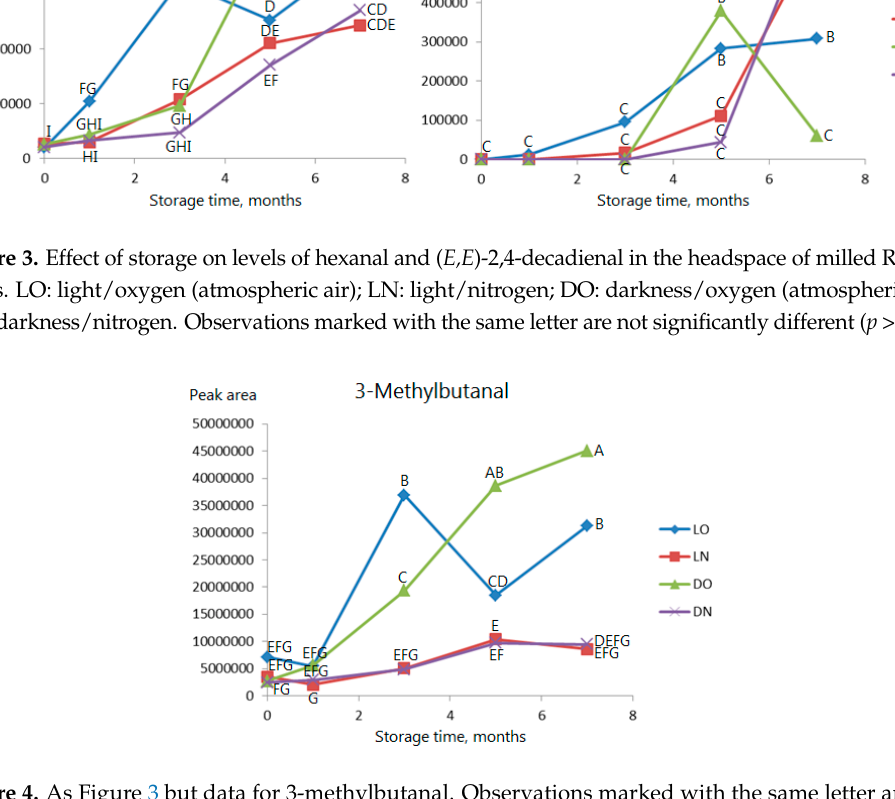
Figure 4. As Figure 3 but data for 3-methylbutanal. Observations marked with the same letter are not significantly different ( p > 0.05).